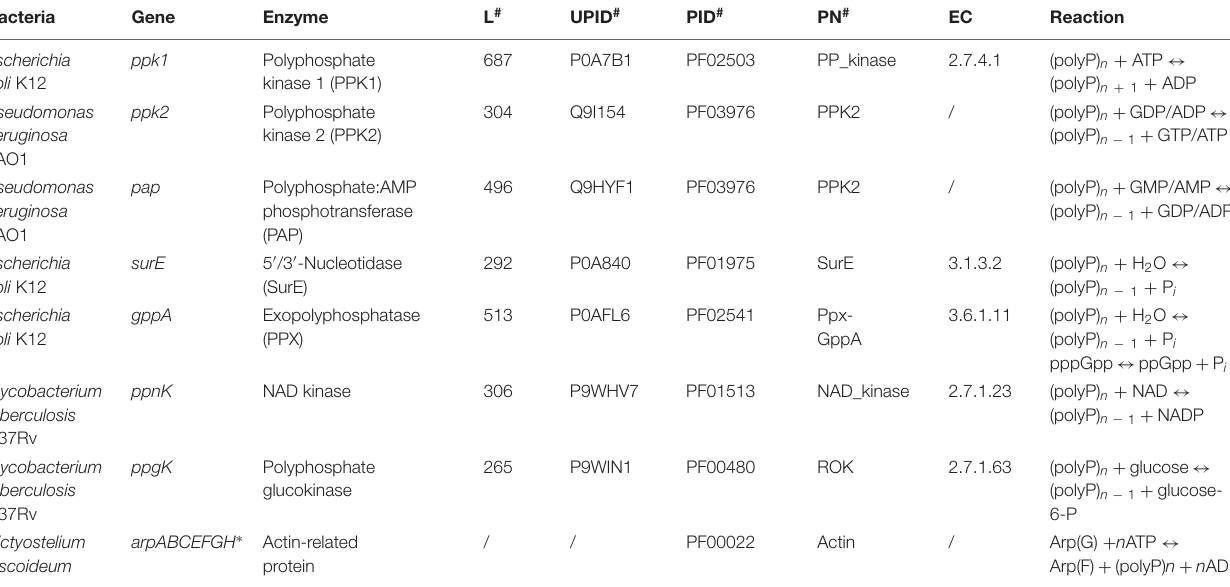
TABLE 1 | Representative reactions directly involved in bacterial polyphosphate metabolism pathways. Bacteria Gene Enzyme L # UPID